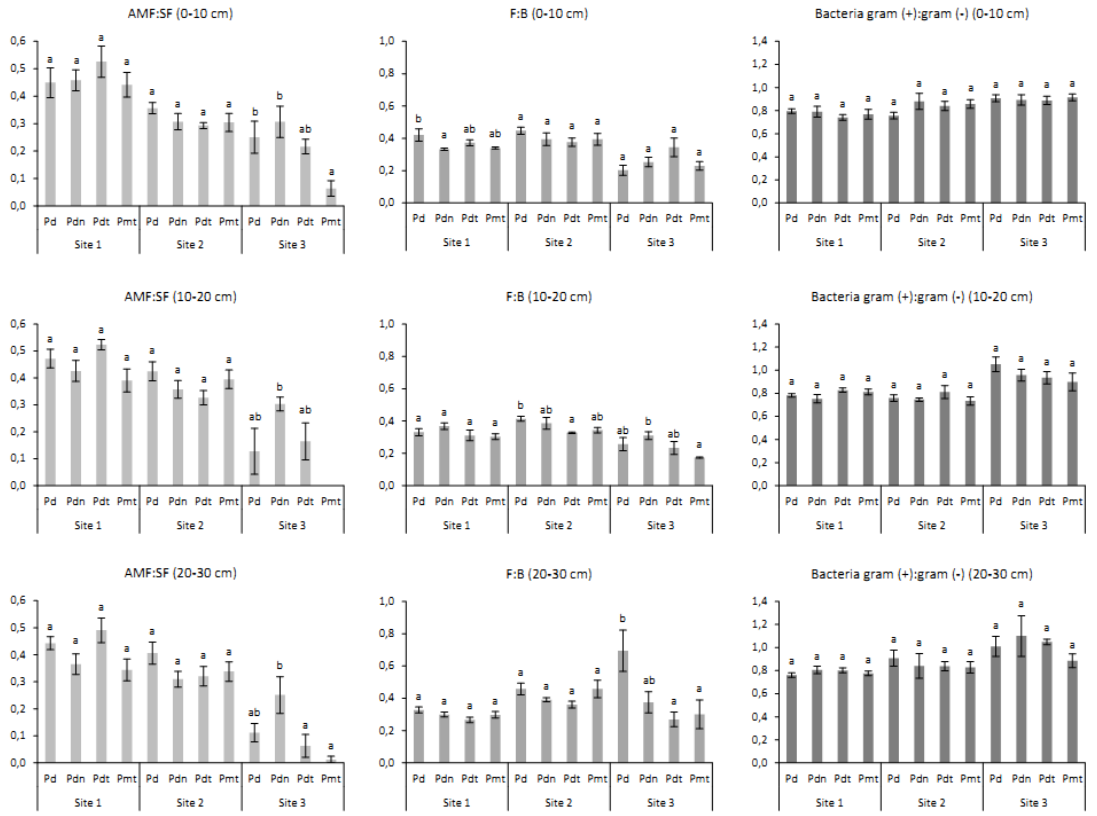
Figure 4. AMF to SF biomass ratio (arbuscular fungi to soil fungi biomass ratio), fungal to bacterial biomass ratio (F:B) and gram-positive to gram-negative bacteria biomass ratio in soils planted with four poplar genotypes, in three sites and at three soil depths. Differences in microbial biomass ratios between poplar genotypes were analyzed separately for each site. Significant differences are indicated by different letters (means±SE, p < 0.05, Tukey’s test).